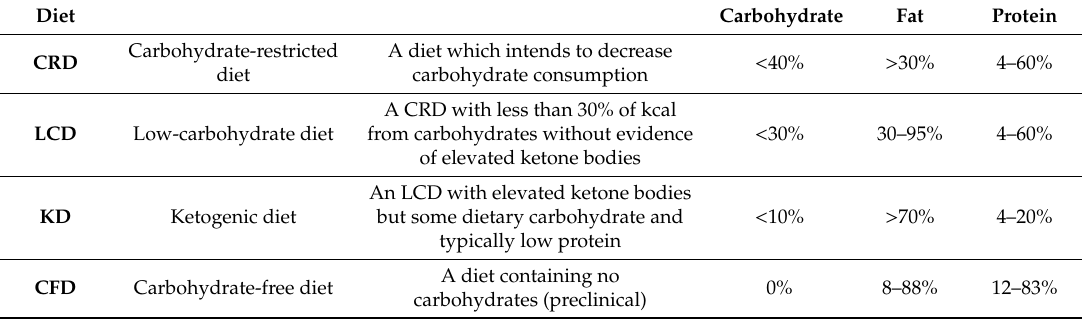
Table 1. Dietary definitions used for the purpose of this review. Percentages are percent of